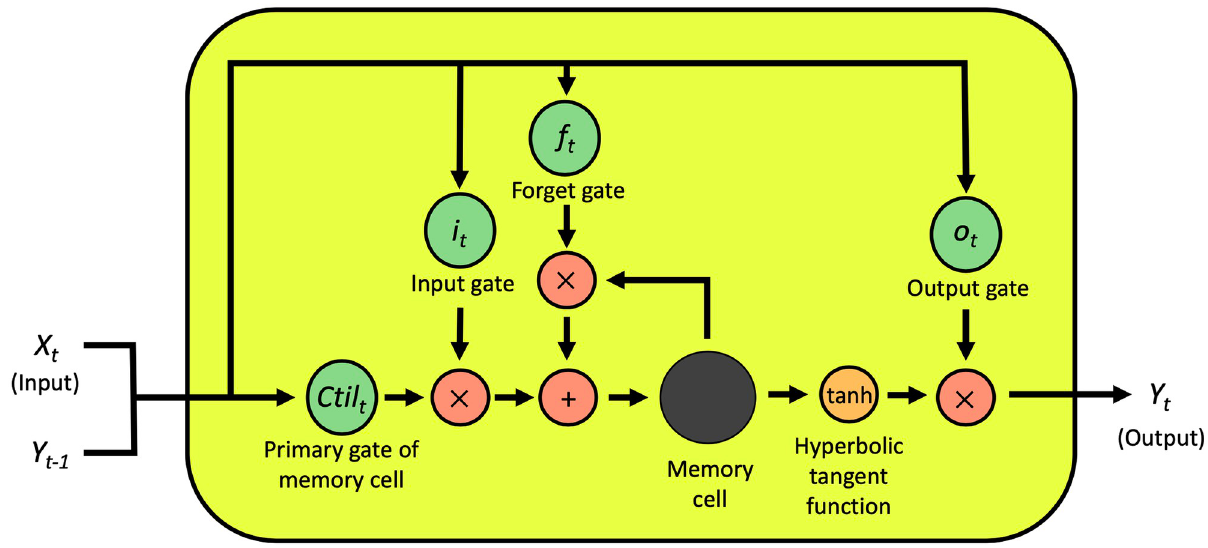
Fig 1. Summary of LSTM model. The formula of each step was described in 2.2. LSTM section.